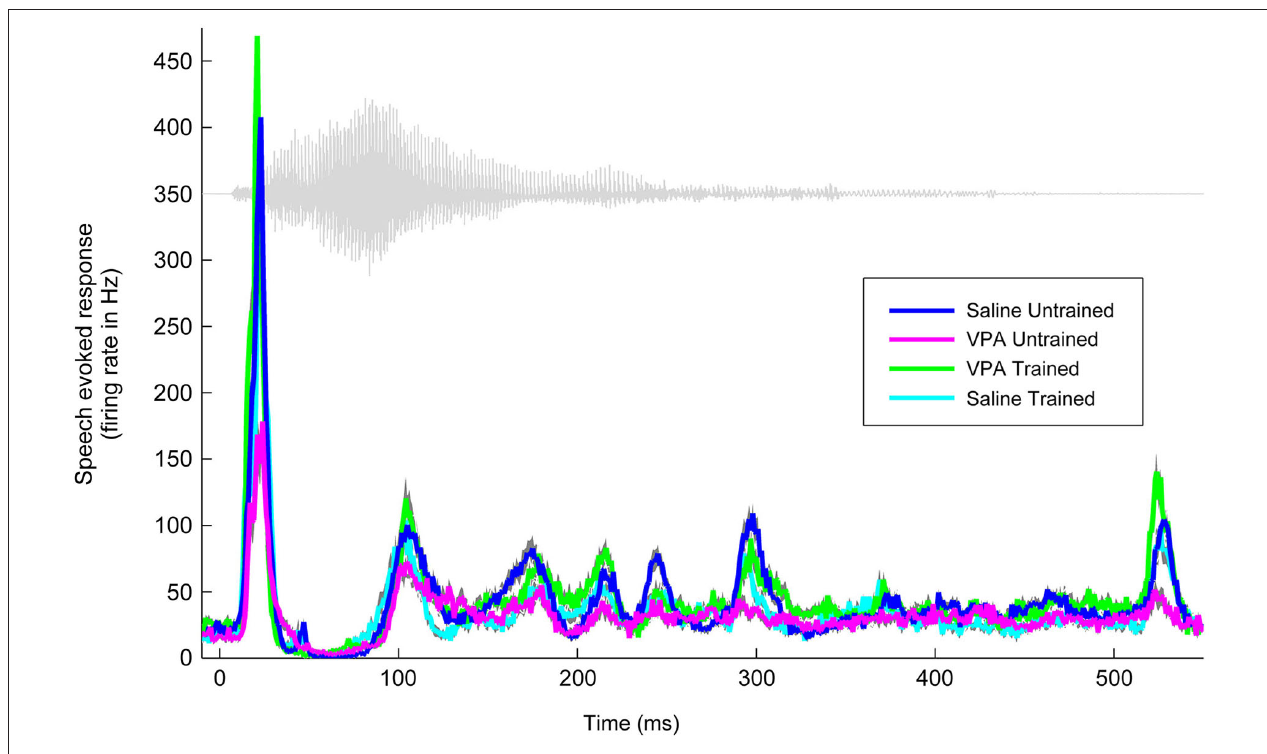
saline untrained rats ( n = 6 rats; blue line) and saline speech trained rats ( n = 4 rats; cyan line). Gray shading indicates s.e.m. across recording sites. The waveform for the speech sound “gad” is plotted in gray.